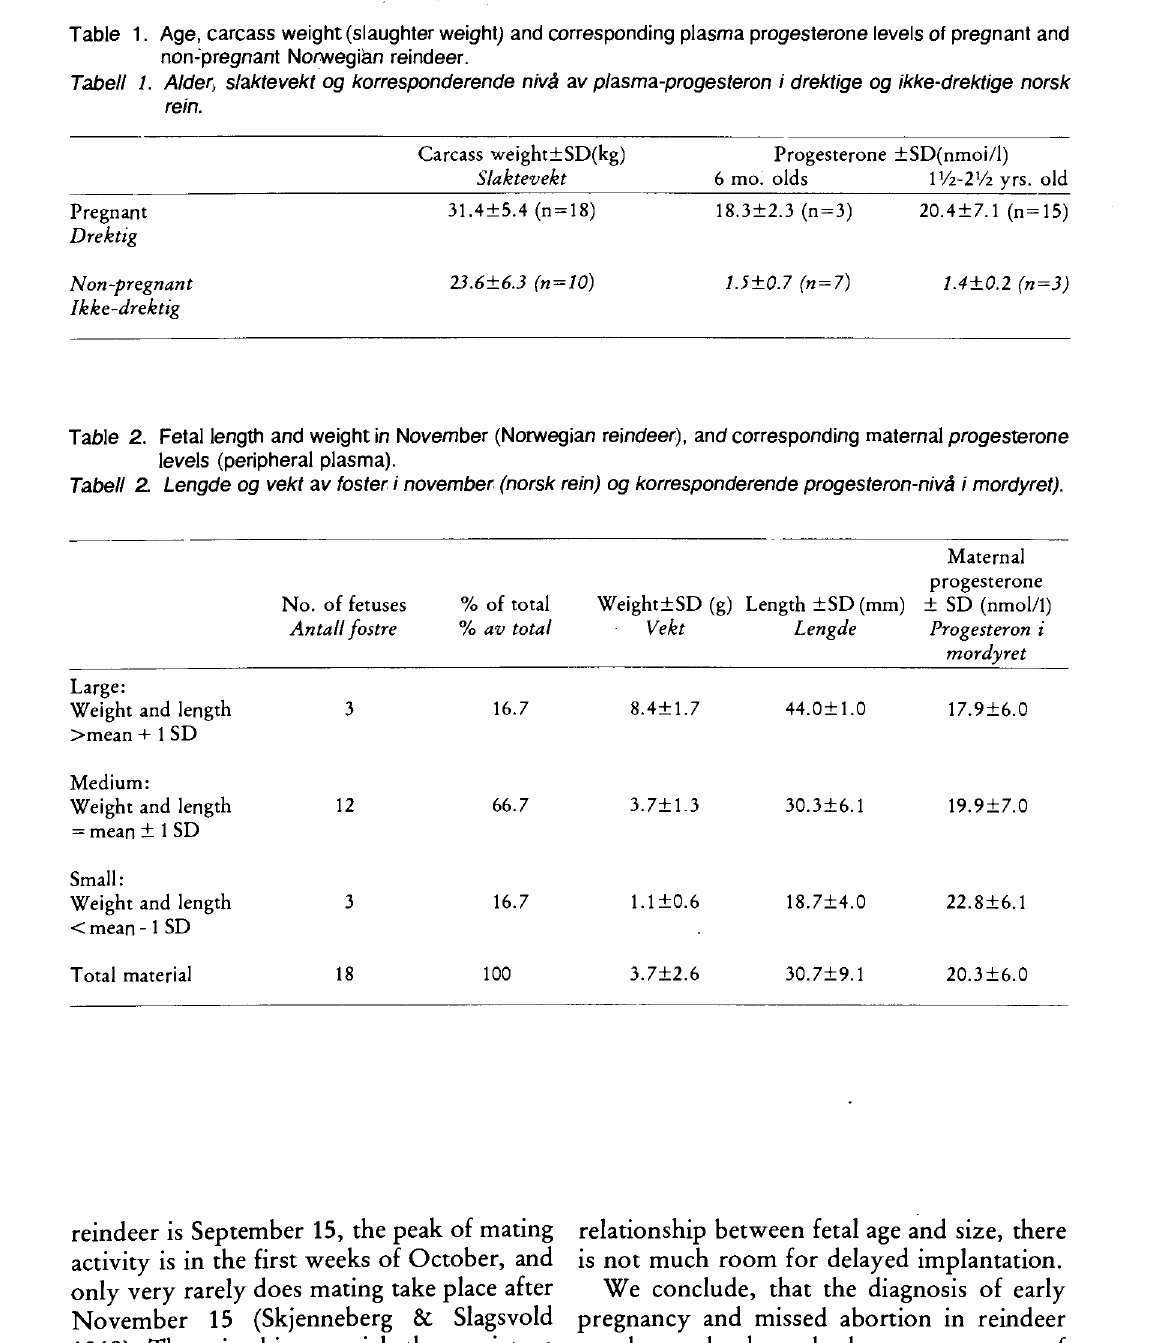
Table 1 . Age, carcass weight (slaughter weight) and corresponding plasma progesterone levels of pregnant and non-pregnant Norwegiån reindeer. Tabell 1. Alder, slaktevekt og korresponderende